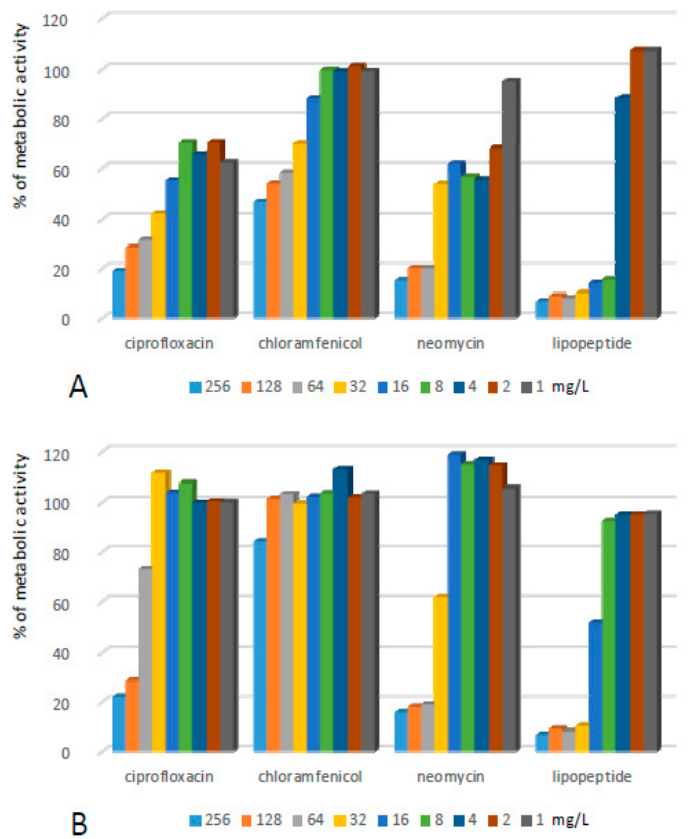
Figure 2. Activity of the lipopeptide and conventional antimicrobials applied at concentrations of 1–256 mg/L against SA biofilms formed on polystyrene ( A ) results read after 24 h exposure to compounds; and ( B ) results read after the withdrawal of compounds and an additional 24 h of incubation in MHB II. The results are presented as the percentage of metabolic activity in comparison to positive (100%) and negative (0%) controls; RSD ≤ 15%.